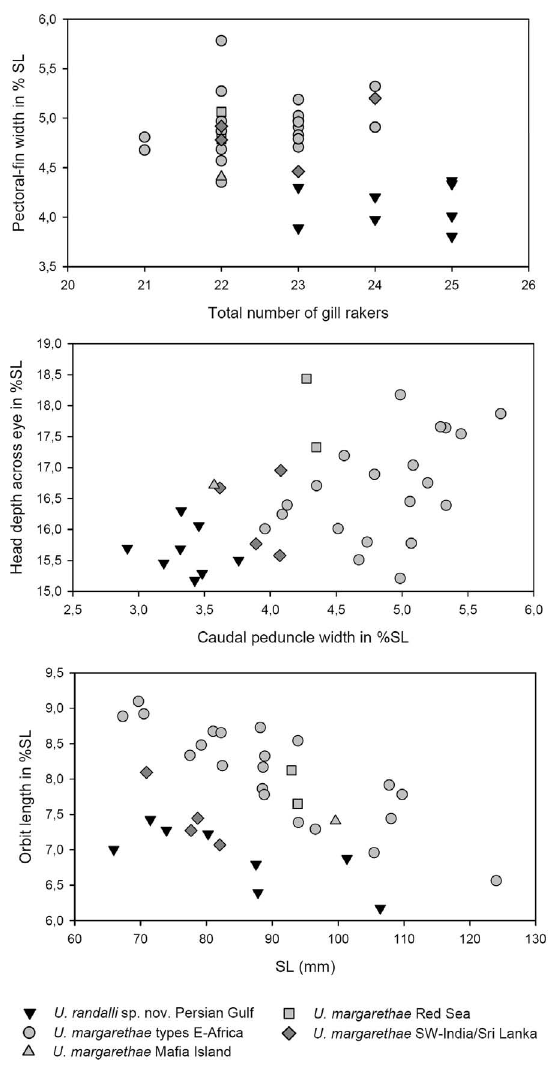
Fig . 2. – Pectoral-fin width against gill-raker number (on top), head depth through eye against caudal-peduncle width (below), and orbit length against SL (on bottom) in Upeneus randalli n. sp. from the Persian Gulf and U. margarethae from the western Indian